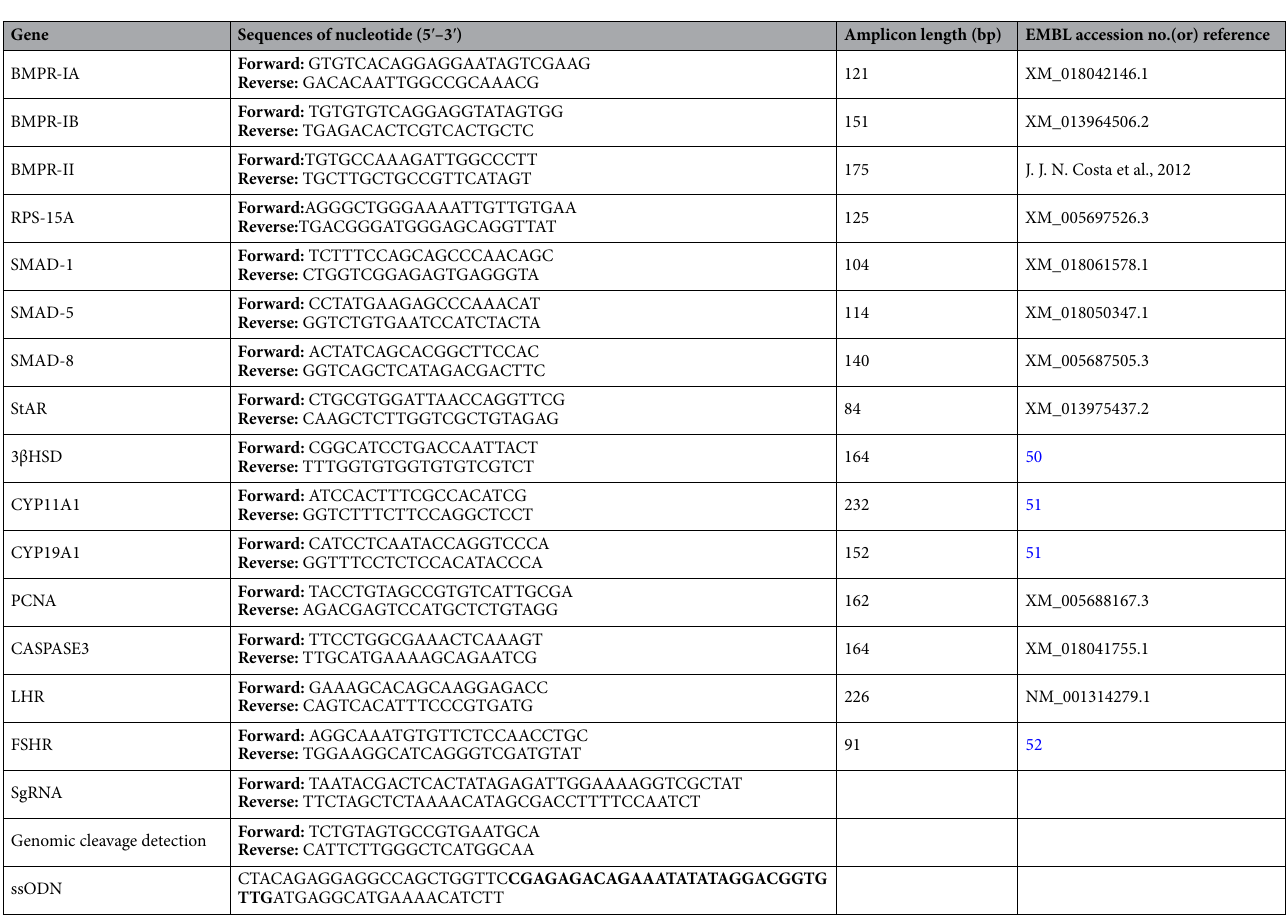
Table 1. Primer sequences used for target genes in the current